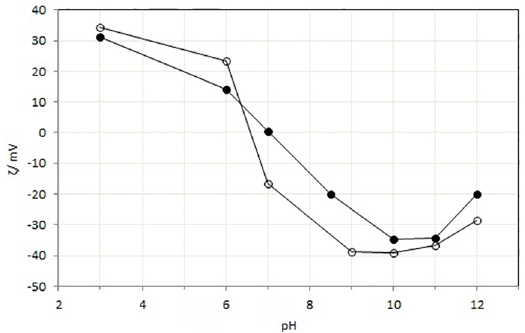
Figure 1. Zeta potential as a function of pH. Alumina-suspension (closed circles) and HA-suspension (open circles, 0.1 wt%). Each value corresponds to the average of three readings. The lines are just to guide the eyes.